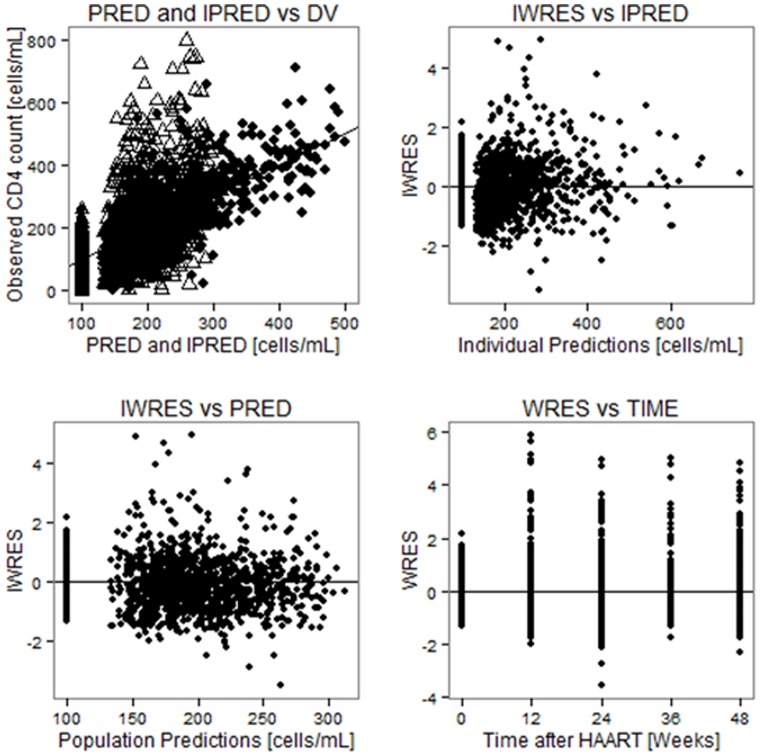
Basic goodness of fit plots for the final model, PRED and IPRED versus DV are plotted on same graph with IPRED VS DV shown by black, square points.PRED = Population prediction, IPRED = Individual prediction, DV = Observed CD4 cell counts, WRES = Weighted residuals, IWRES = Individual weighted residuals.